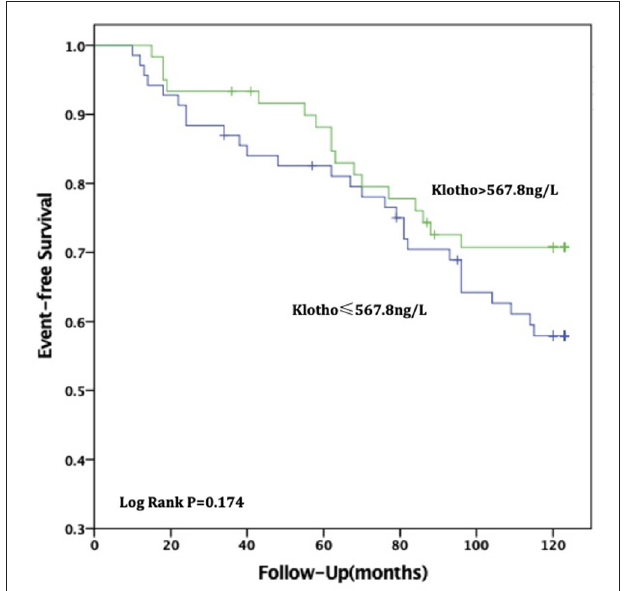
FIGURE 3 | Relationship between soluble Klotho level and CVD mortality in MHD patients. For CVD death, patients in high soluble Klotho level (sKl > 567.8 ng/L) had a significant long survival time than in the low soluble Klotho level (sKl ≤ 567.8 ng/L). Kaplan-Meier analysis with log-rank test revealed a significant difference between groups ( P =